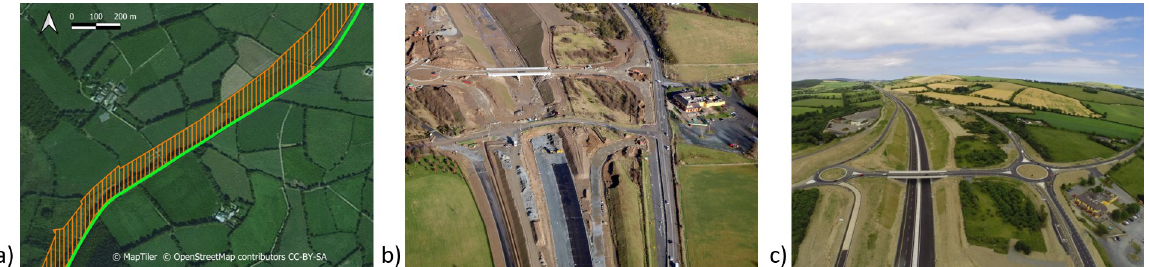
Fig 1. Road construction phases. a) ‘Before’—satellite image of part of the study area before road construction. The hatched orange area indicates the location of the M11 motorway construction zone adjacent to the N11 road. The N11 is represented by the green line. b) ‘During’— aerial photograph of part of the study area taken during road construction revealing the extent of the change to the habitat. The N11 can be seen to the right-hand side of the photograph. c) ‘After’—aerial photograph of part of the study area taken upon completion of road construction. The motorway and access roads were completely enclosed in continuous badger-proof